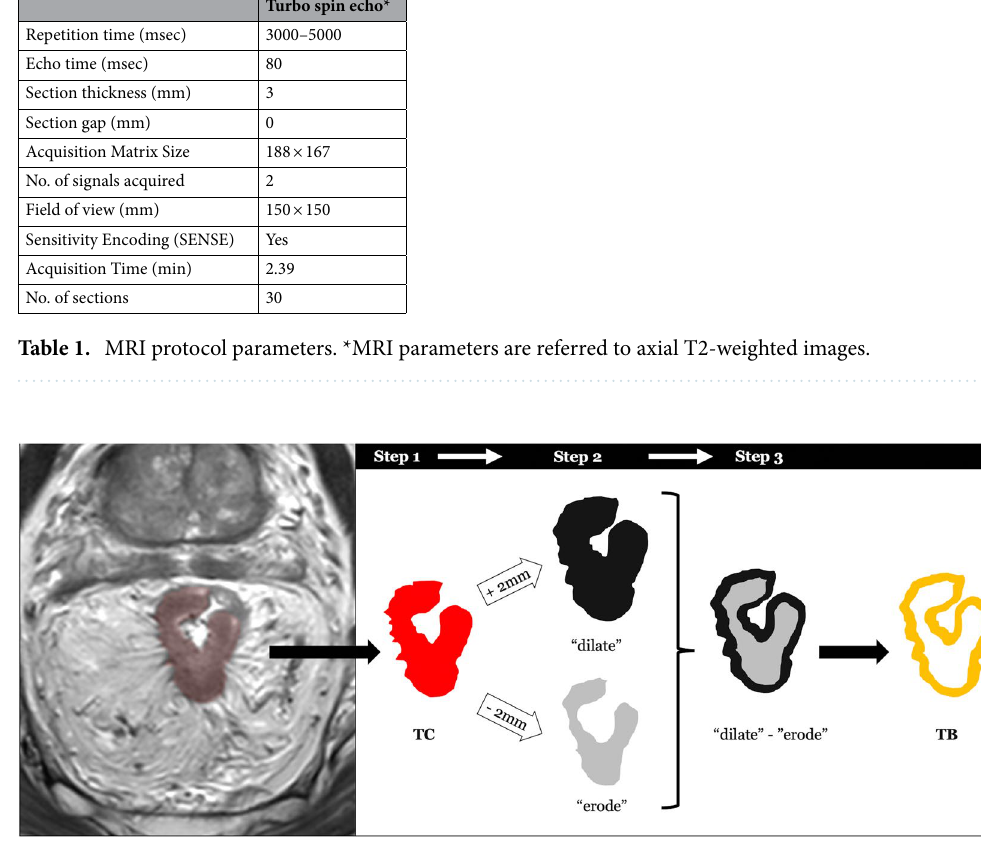
Figure 2. The segmentation process was as follows: in the first step, the whole tumor was manually segmented on axial T2w images and labeled as tumor core (TC). In the second step, the edge of TC was dilated (“dilate”) and eroded (“erode”) by 2 mm, respectively. In the final step, we overlapped the dilated and eroded masks, and subsequently subtracted them to obtain the tumor border (TB). Thus, the TB obtained included the most peripheral portion of the TC and the surrounding